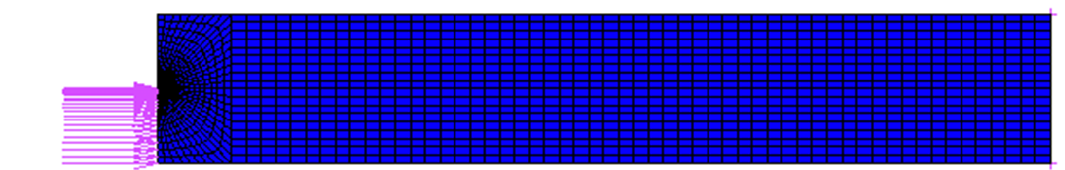
Figure 2: Finite element mesh for SENT and CCBT (a/W and a/R=0.5). Same mesh but different element type: plane strain for SENT, axisymmetric for CCBT.